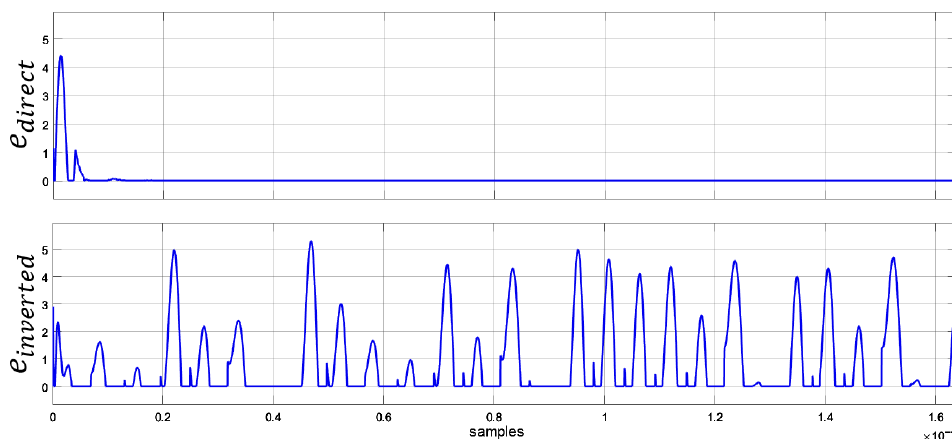
Figure 6. Absolute value of the synchronization error signal at the direct (upper graph) and inverted (lower graph) output signal of the master chaos generator applied to the slave generator.